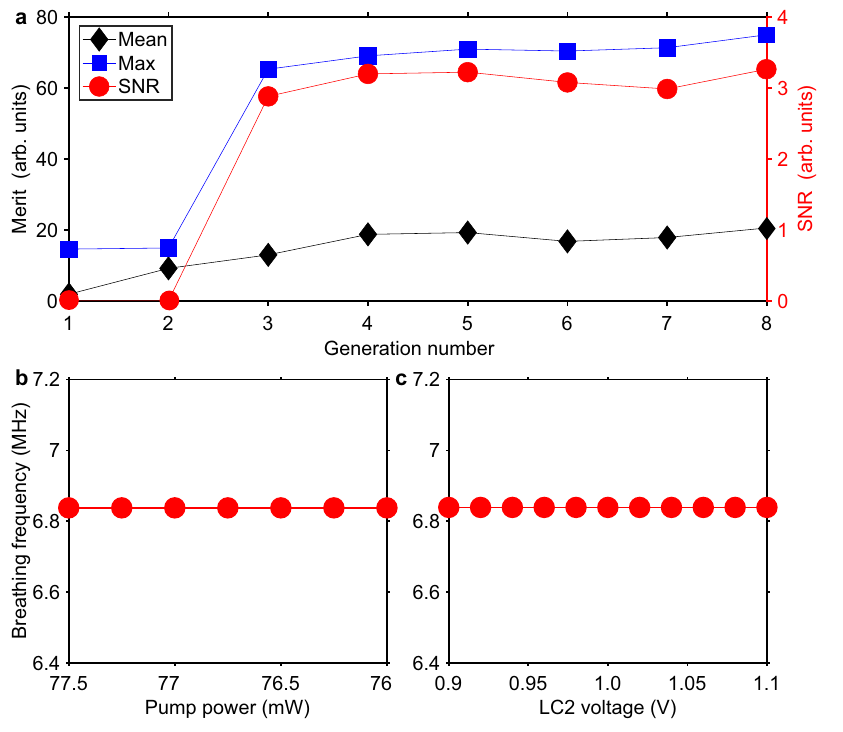
Fig. 4 | The machine-learning results. a Evolution of the mean (black diamonds) and best (blue squares) merit scores of the individuals for each generation. Also shown is the corresponding evolution of the SNR (signal-to-noise ratio) of the